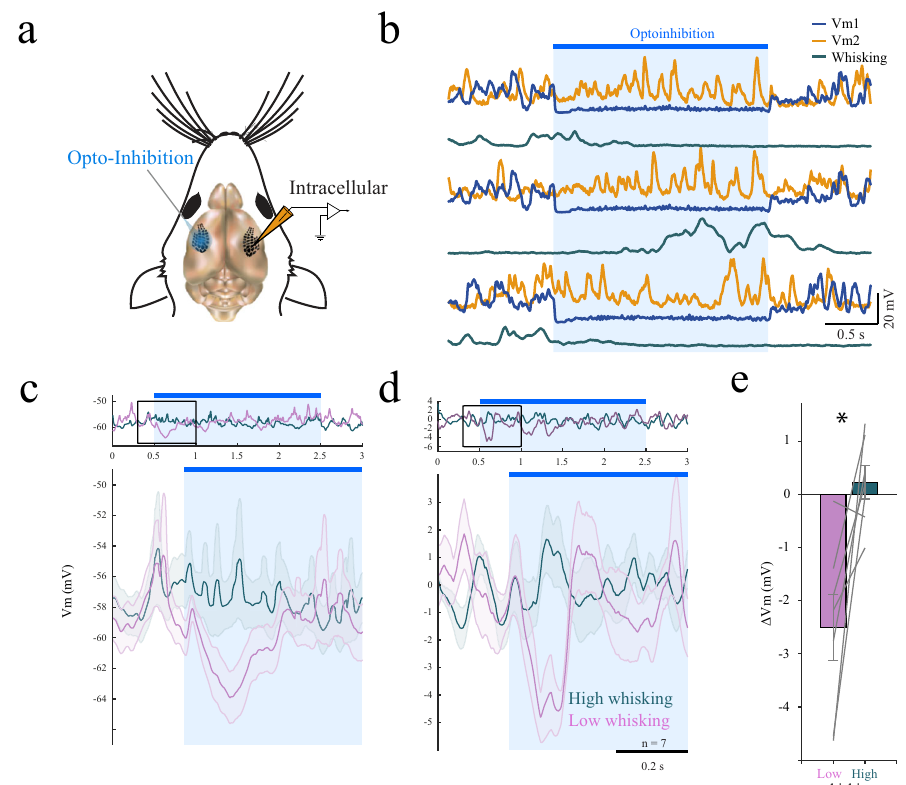
Fig. 3 Interhemispheric coupling is reduced during whisking. a Paired intracellular recordings in the right and left barrel cortices of head- fi xed GAD-ChR2 mouse on a linear treadmill. b Example traces for paired intracellular recordings from right (orange) and left (blue) hemispheres shown together with whisking trace (teal). The left (blue) hemisphere was inactivated by light (blue bar), thus silencing ongoing activity in that hemisphere (Vm1, Vm2- membrane potential of the cells). c Example data form one neuron showing mean membrane potential for epochs of high whisking (teal) and low whisking (pink). During optogenetic inhibition (marked in blue) transient hyperpolarization was prominent only during low-whisking epochs (pink). d Population average of membrane-potential traces ( n = 7 neurons) as in c . e Voltage change due to light for the low and high-whisking trials averaged across all pairs ( Δ Vm = difference between mean membrane potential during fi rst 200 ms following light inactivation and mean baseline Vm before light (800 ms), mean ± SEM, p = 0.002, two-sided WSRT, n = 7